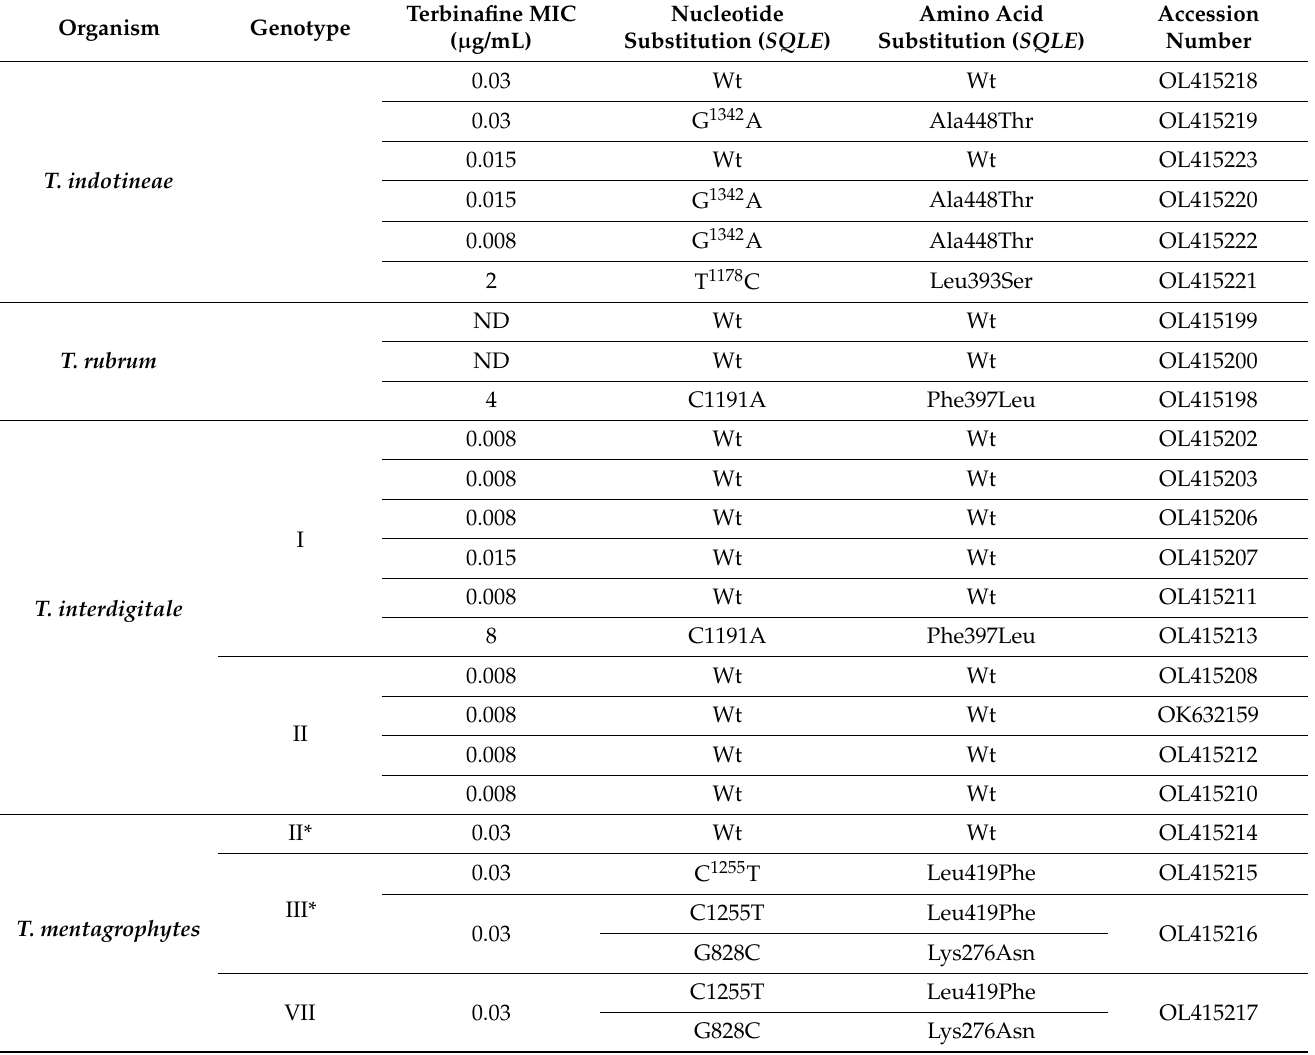
Table 4. Squalene epoxidase enzyme sequencing of 3 TerR and 20 susceptible isolates collected in the Paris area,